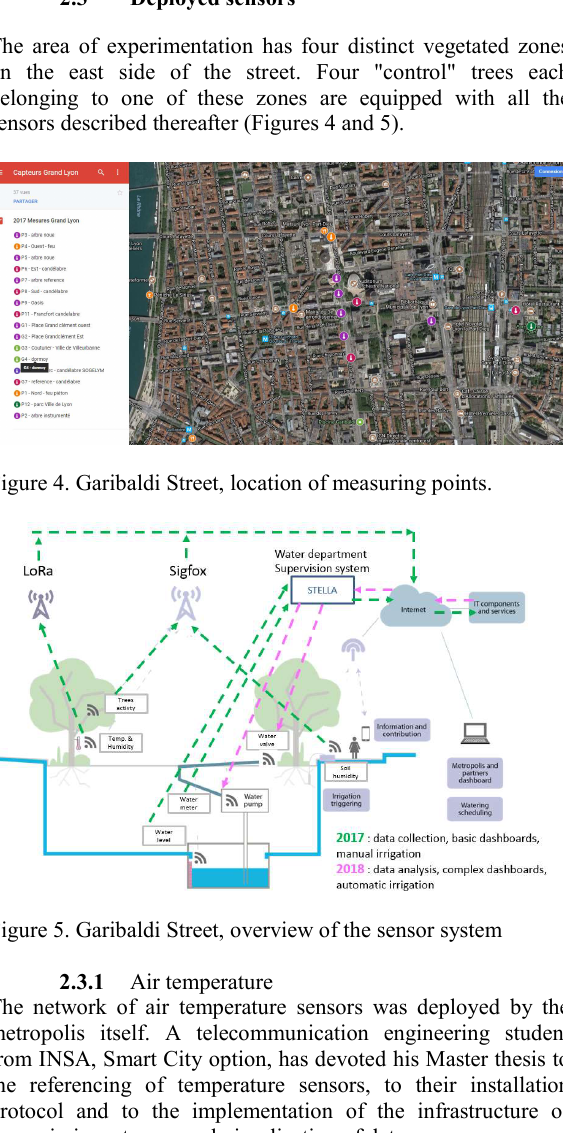
Figure 3. Garibaldi Street: Storm water recovery and watering of green spaces.